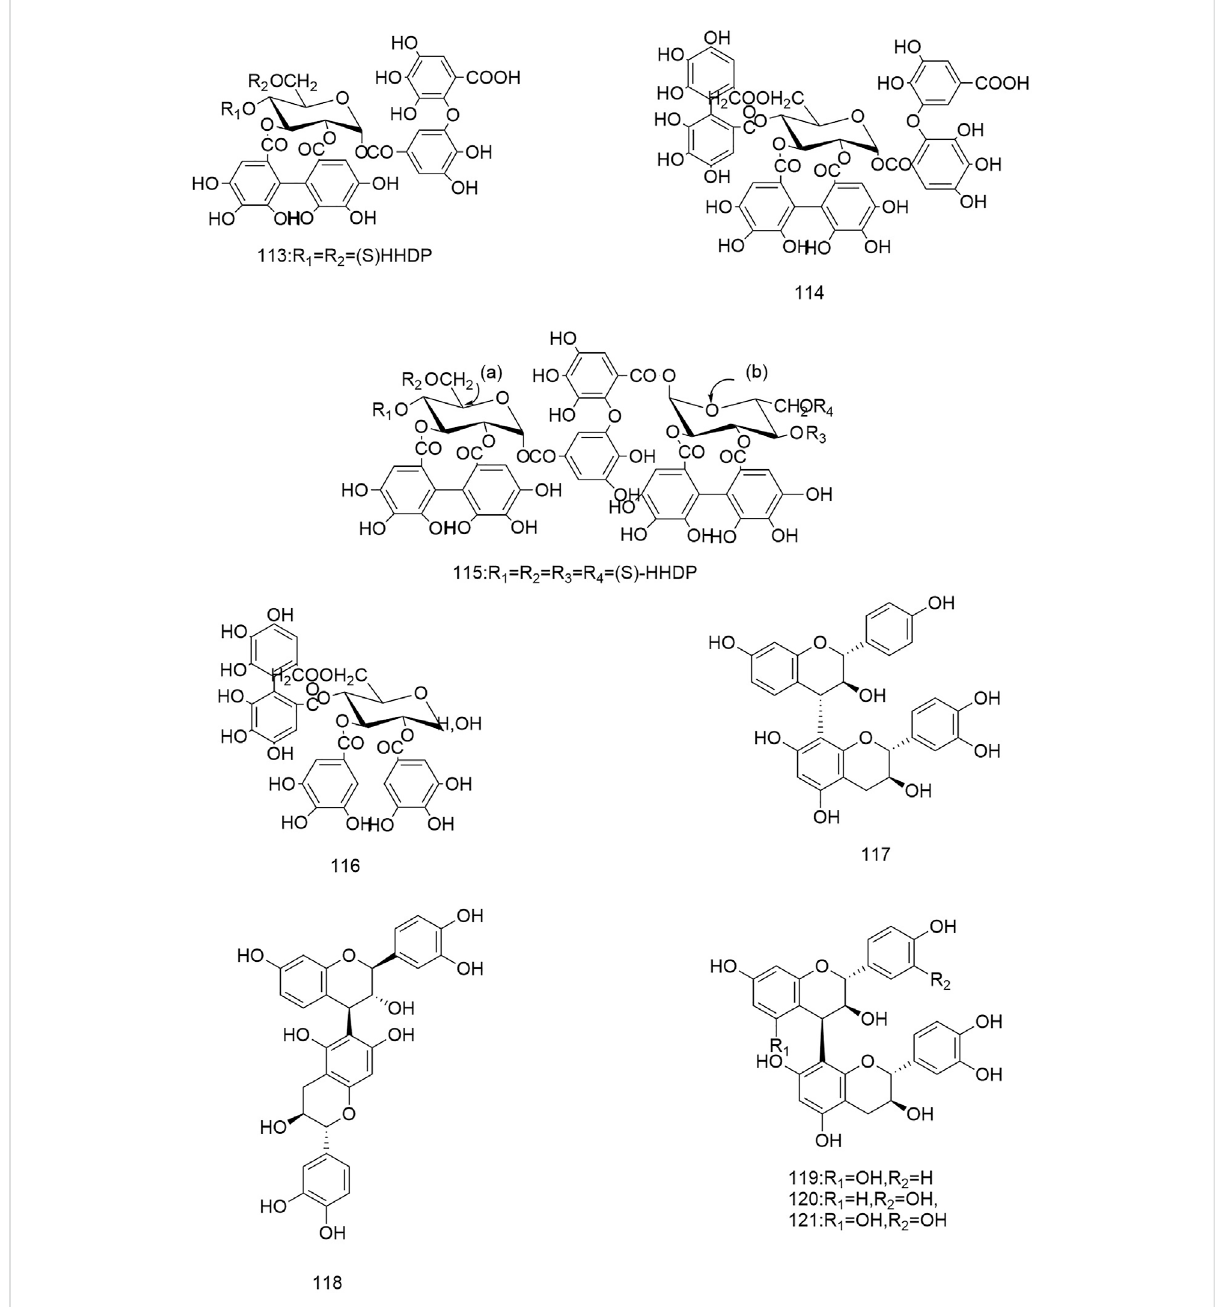
FIGURE 5 Diagrammatic representation of the structural formulas of tannins of compounds found in R. laevigata